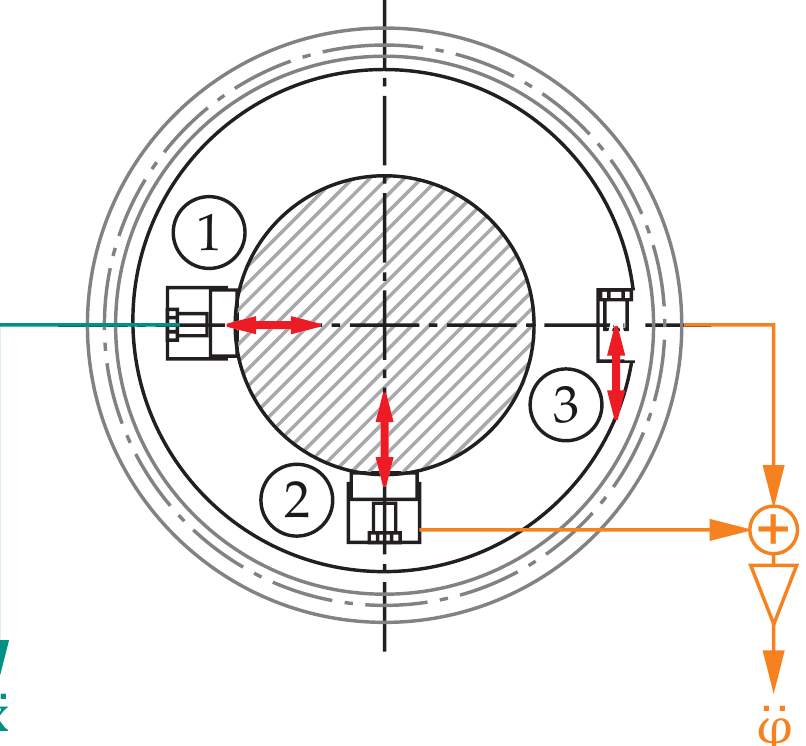
Figure 7. Measurement disc and sensor position for torsional acceleration measurement: 1–2-radial sensors, 3-tangential sensor according to